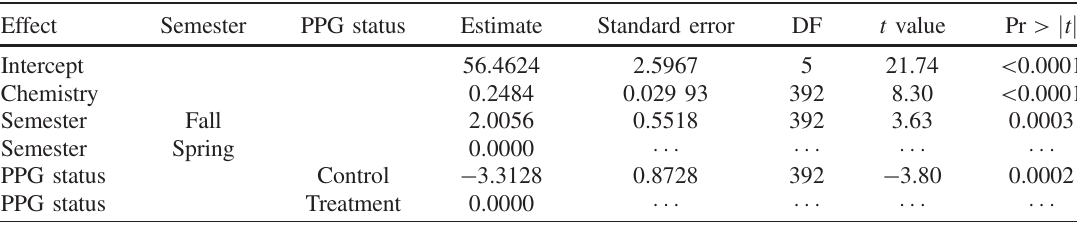
TABLE VII. Model results for semester physics performance.